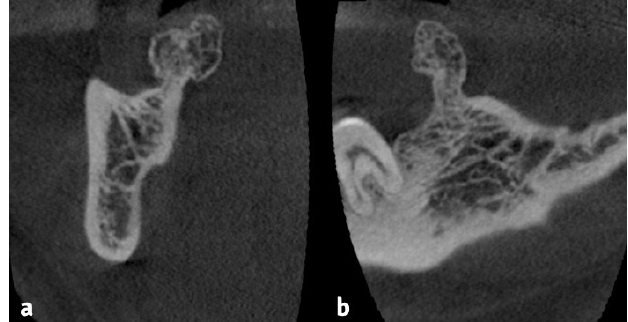
Fig. 3. CBCT: tumor with lingual pedicle on the right mandibular ridge, osseous density with a border of condensation. a: frontal section. b: sagittal section.